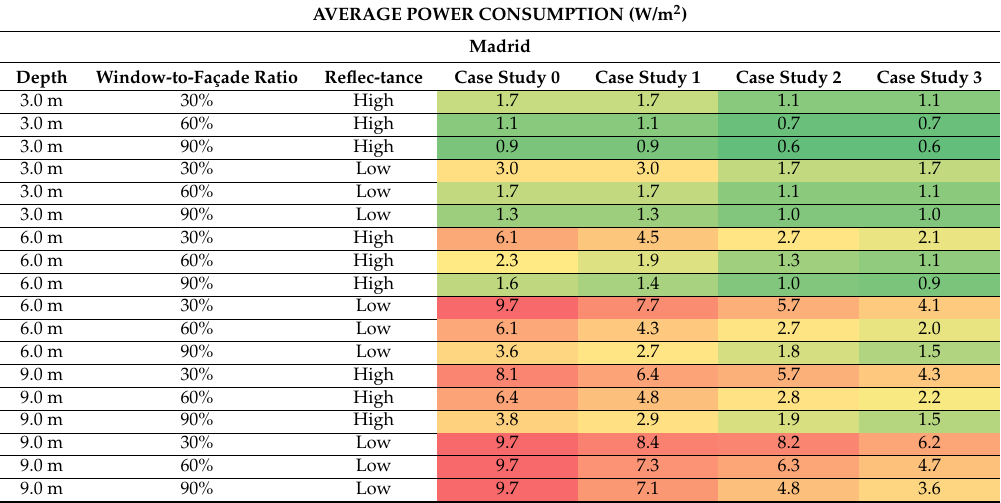
Table 10. Average power consumption in W/m 2 of different lighting smart controls in